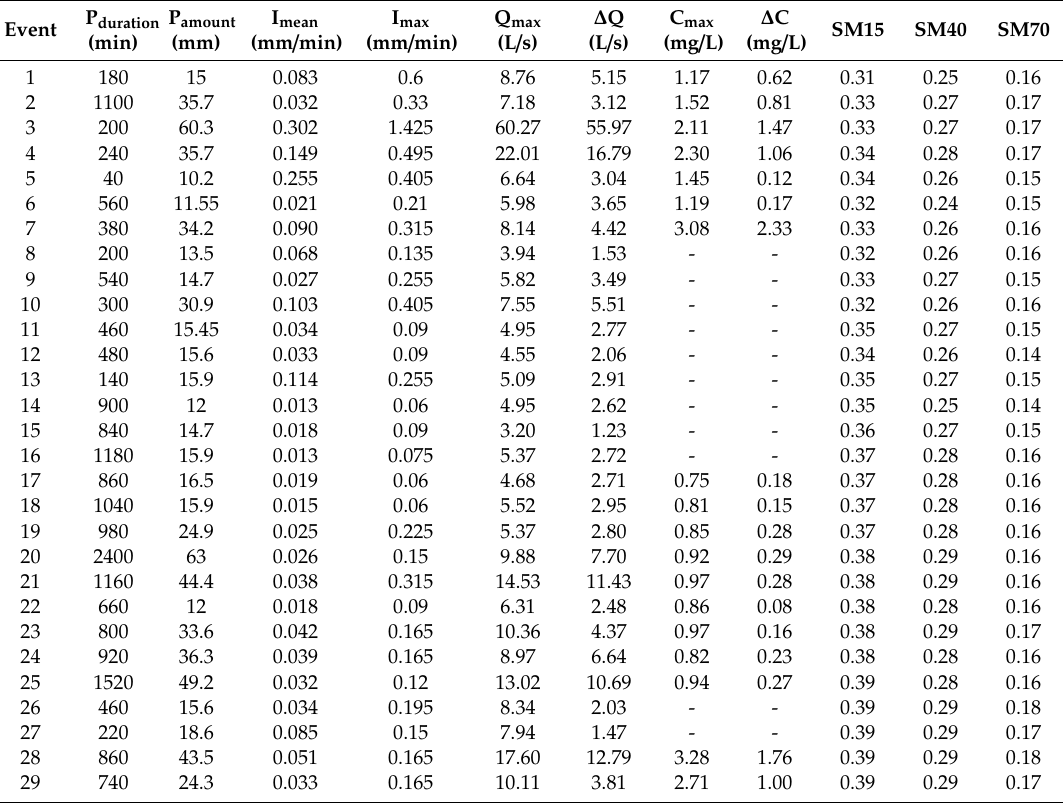
Table 1. General information about 29 rainfall events. P duration and P amount are duration and amount of rianfall, respectively, I mean and I max are mean and average rainfall intensity, respectively, Q max and C max are the maximum discharge and NO 3 -N concentration respectively, ∆ Q and ∆ C are range of discharge and NO 3 -N concentration respectively, SM15, SM40, and SM70 are the average soil moisture values in m 3 / m 3 at 15, 40, and 70 cm, respectively. ∆ Q and ∆ C are calculated as the di ff erence between maximum and minimum value of the individual event.